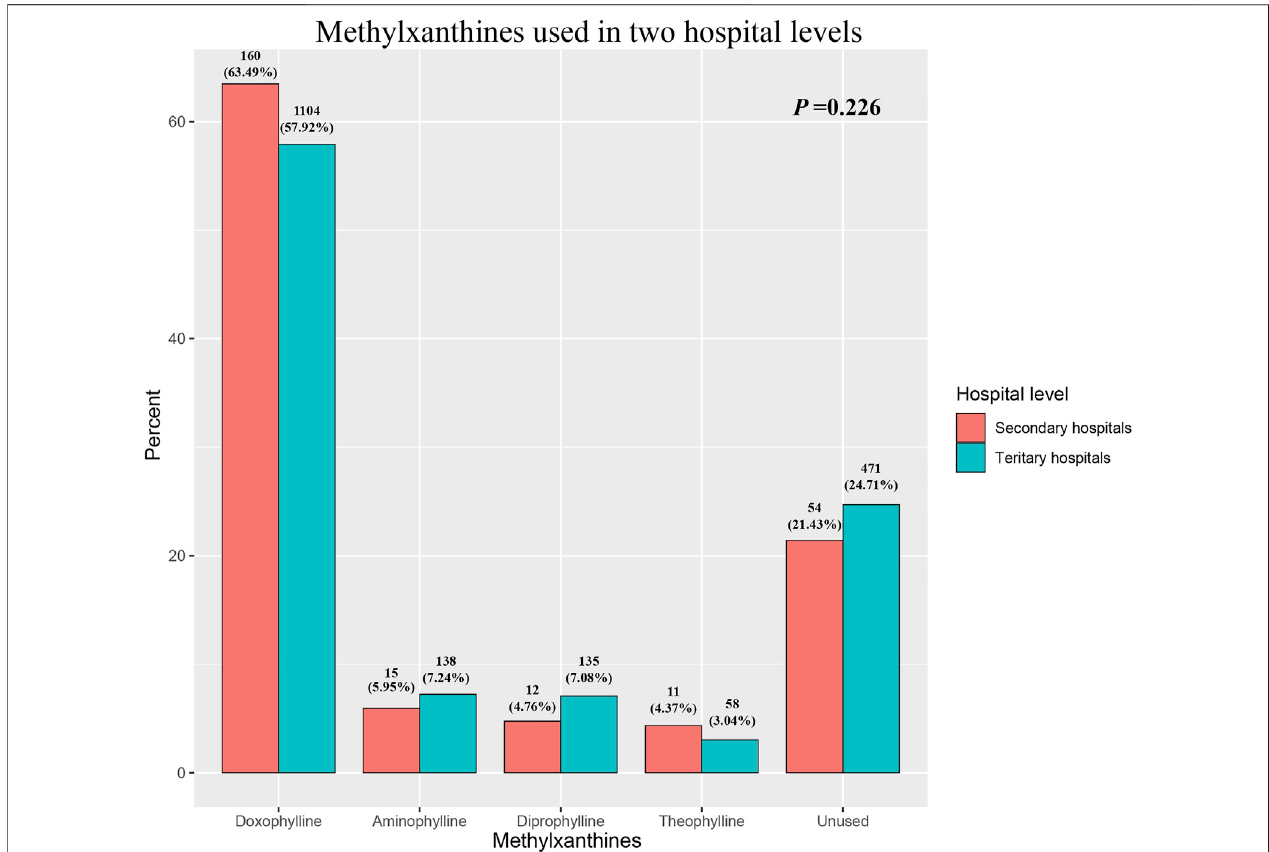
FIGURE 2 | The distribution of methylxanthines used in two hospital levels.